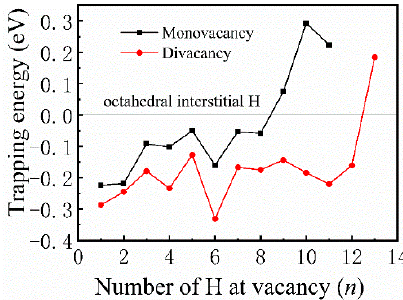
Figure 3. Trapping energies as a function of the number of H atoms embedded in monovacancy and divacancy defects.